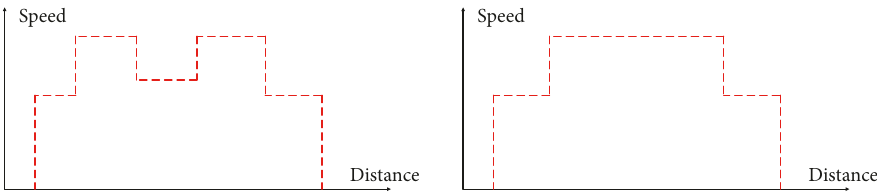
Figure 2: The speed limit of a train with a multiphase